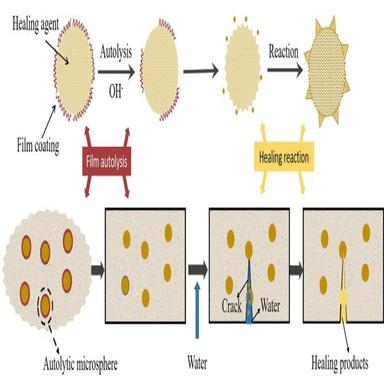
Fundamental concept of autolytic self-healing method for cementitious materials.